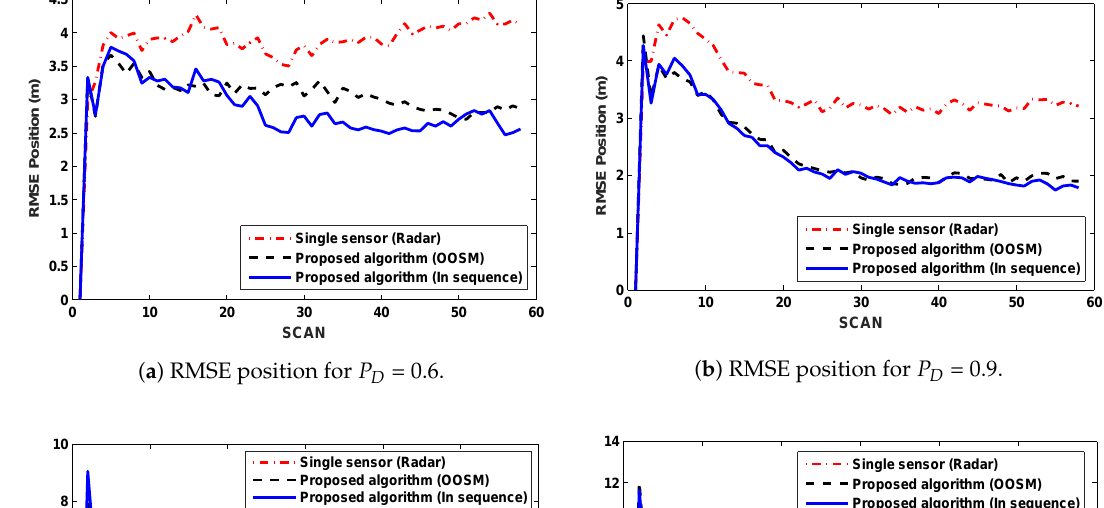
( a ) RMSE position for P D = 0.6. ( b ) RMSE position for P D = 0.9.